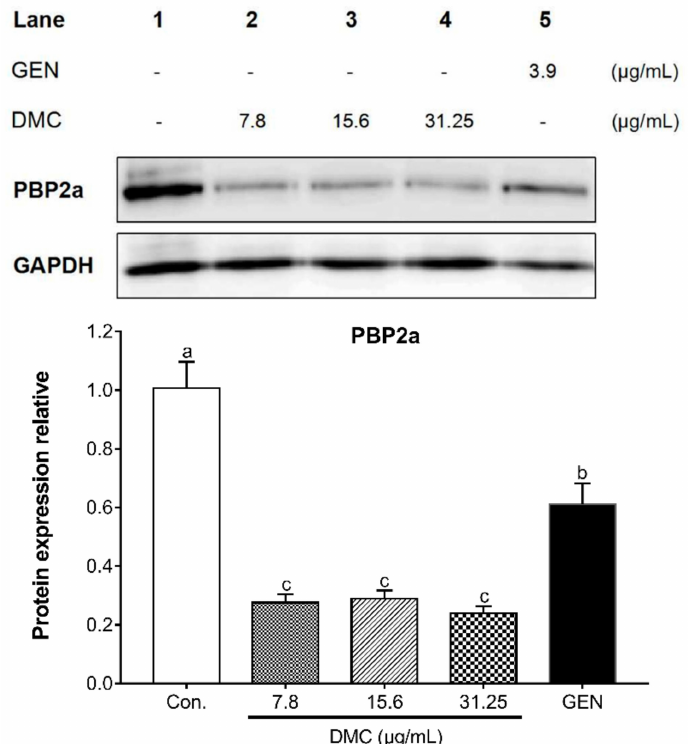
Figure 4. The effect of DMC and GEN on the expression of penicillin-binding protein 2a (PBP2a) in MRSA strain ATCC 33591, as analyzed by western blot. Loading differences were normalized by anti-GAPDH antibody. Lane 1, control (untreated); lane 2, DMC 7.8 µ g/mL (1/8MIC); lane 3, DMC 12.5 µ g/mL (1/4 MIC); lane 4, DMC 25 µ g/mL (1/2 MIC); lane 5, GEN 3.9 µ g/mL. The data are means ± SD of triplicate determinations. Different letters in each bars indicate significant statistical differences between treatments ( p <